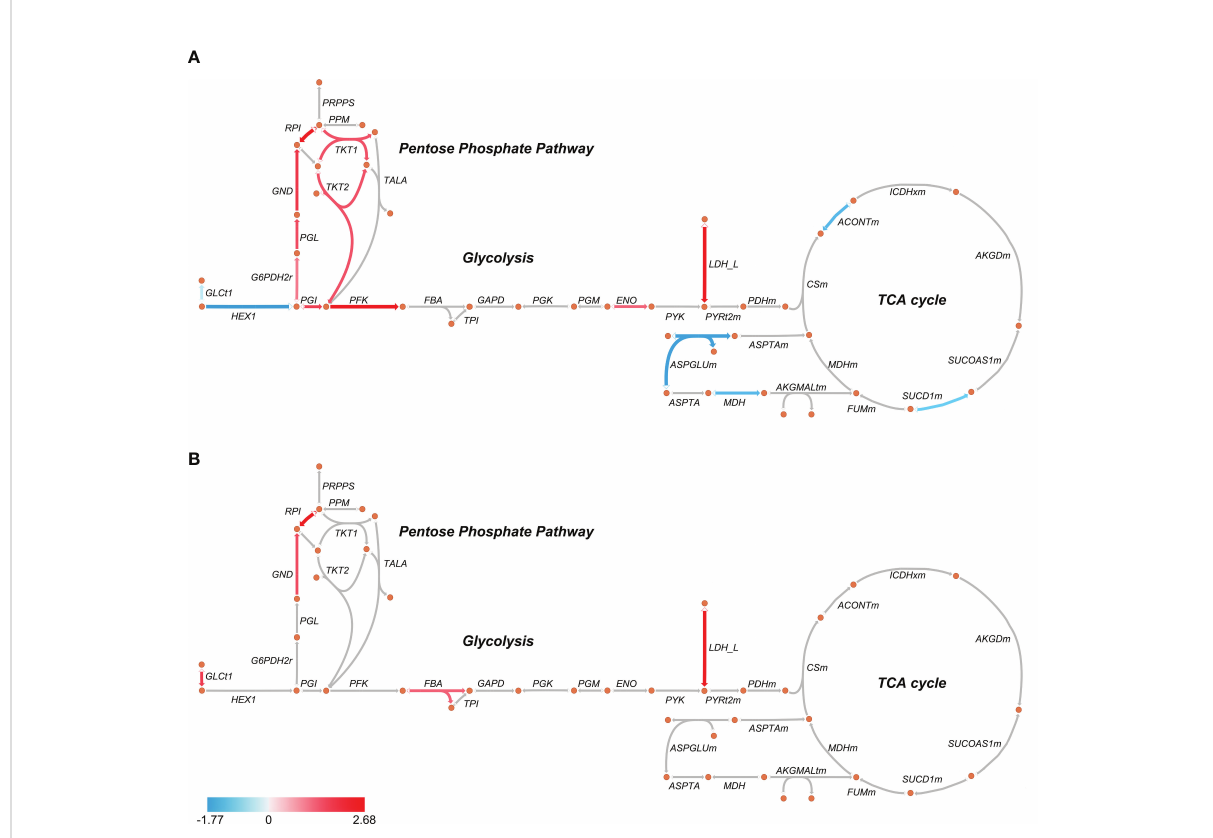
FIGURE 2 Schematic representation of glycolysis, pentose phosphate pathway, and TCA cycle in septic patients ’ PBMCs at D0 (A) and D7 (B) . The arrows indicate enzymes catalyzing each reaction. Red arrows indicate an average upregulation and blue arrows indicate an average downregulation based on the Log 2 (fold-change) compared to healthy volunteers. Metabolic maps were generated using